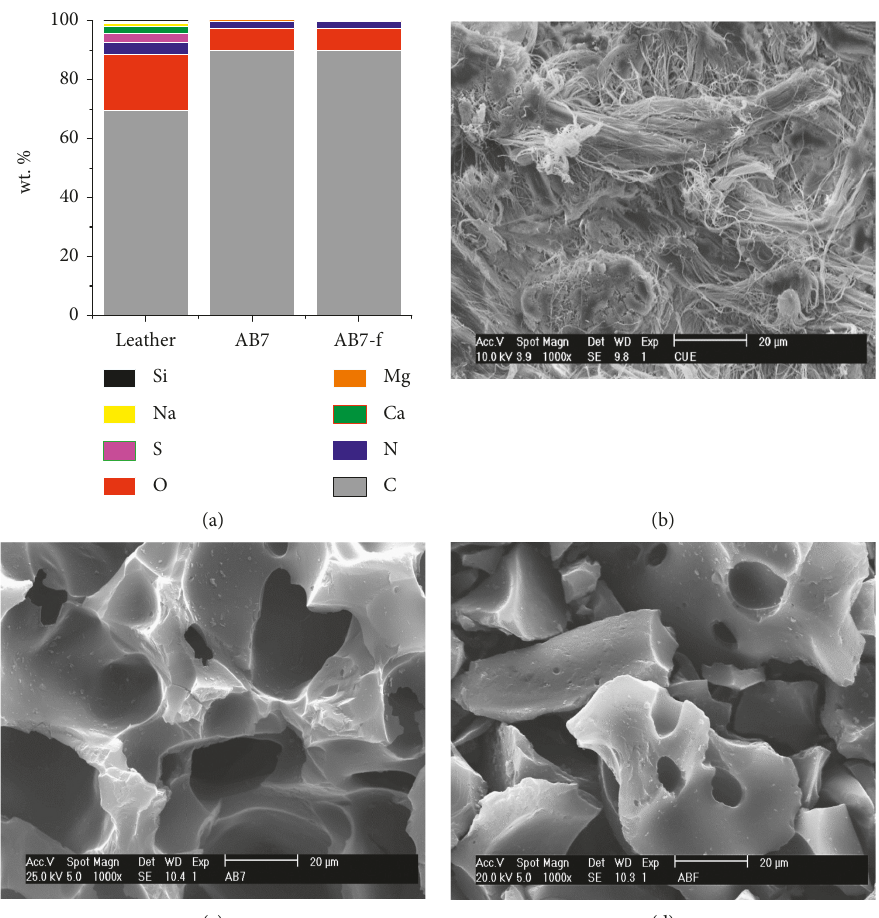
Figure 2: (a) Chemical composition of leather and catalysts determined by EDS and morphology of (b) leather, (c) AB7, and (d)